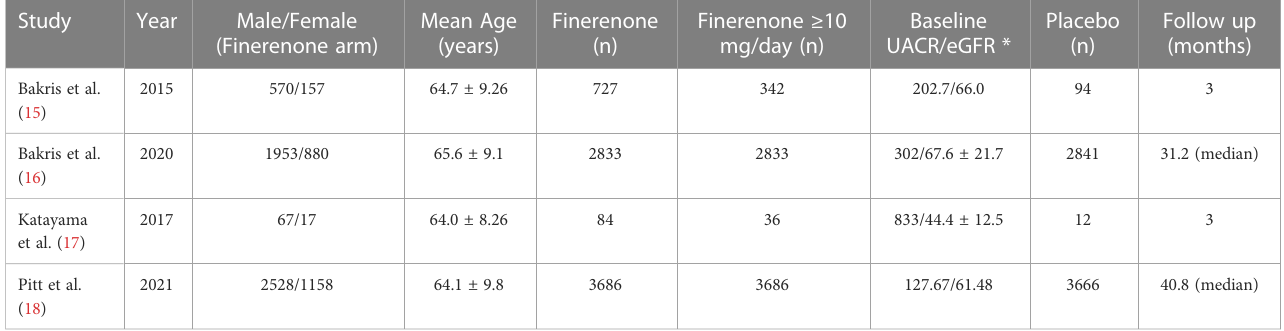
TABLE 1 Baseline characteristics of the citations included for analysis.